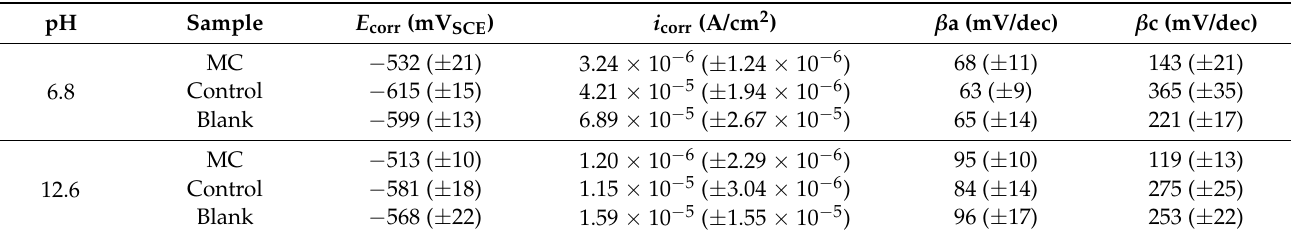
Figure 6. Potentiodynamic polarization curves for mild steel with acrylic coating modified with colophony microcapsules exposed to 3.5 wt% NaCl in ( a ) DI water (pH = 6.8) and ( b ) SCPS (pH = 12.6). Table 3. Electrochemical parameters calculated by Tafel fitting from potentiodynamic polarization for acrylic coating containing microcapsules exposed to 3.5 wt% NaCl contaminated environment in DI water (pH 6.8) and SCPS (pH 12.6). The standard deviation is presented in the parenthesis.